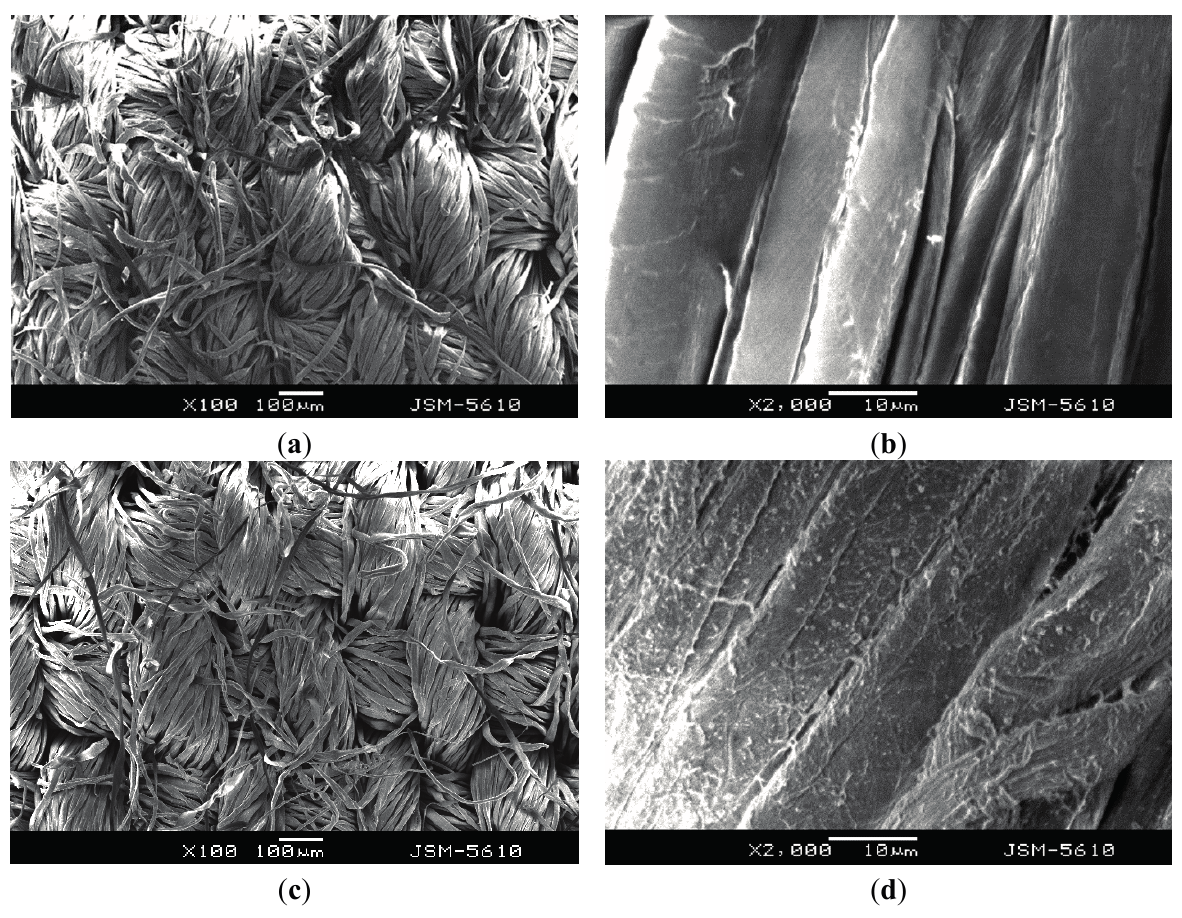
Figure 5. SEM micrographs of cotton fabrics ( a , b ) without treatment; and ( c , d ) after crosslinking with P(NIPAAm- co -NHMAAm)